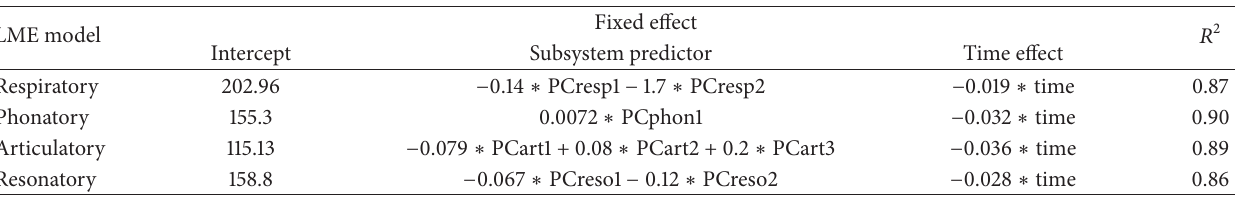
Table 2: Fixed effects and 𝑅 2 values for the LME models of the four subsystems (respiratory, phonatory, articulatory, and resonatory).